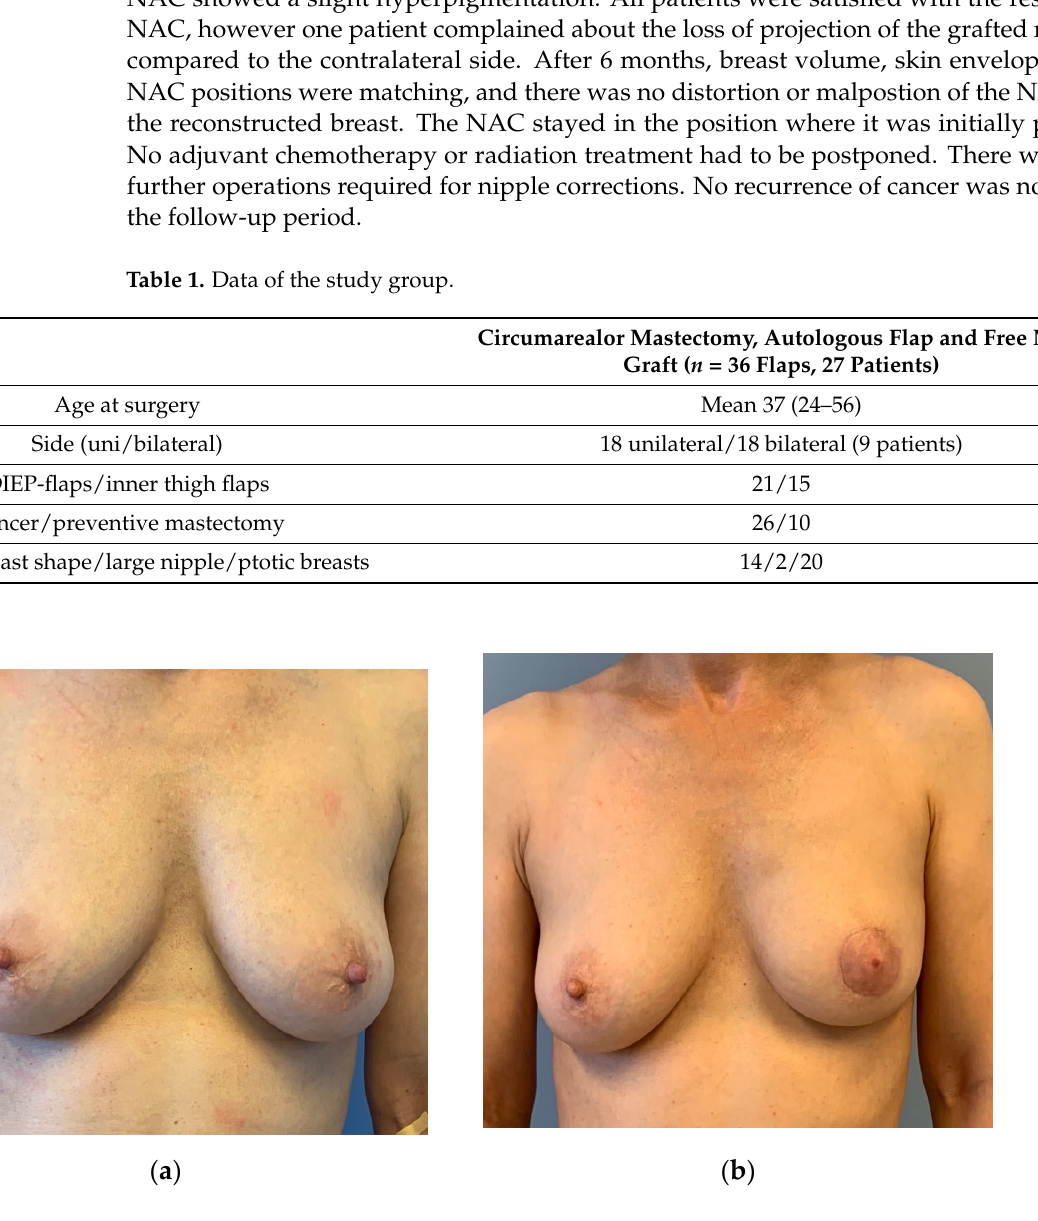
Table 1. Data of the study group.